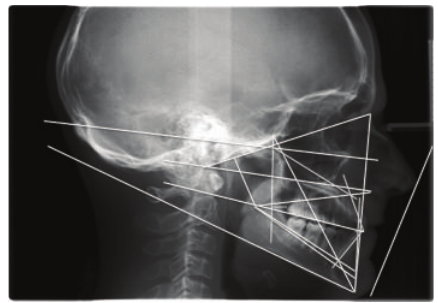
Figure 3: Preoperativelaterolateral teleradiography of the skull and cephalometric